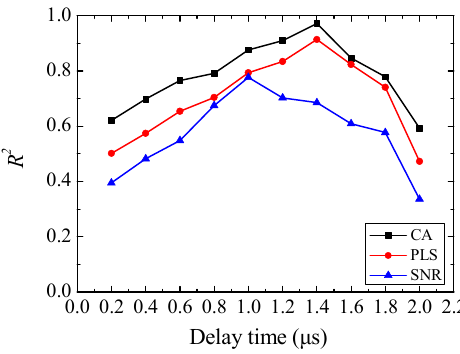
Figure 4. The coefficients of determination, R 2 with various delay times for the CA, PLS, and SNR methods.